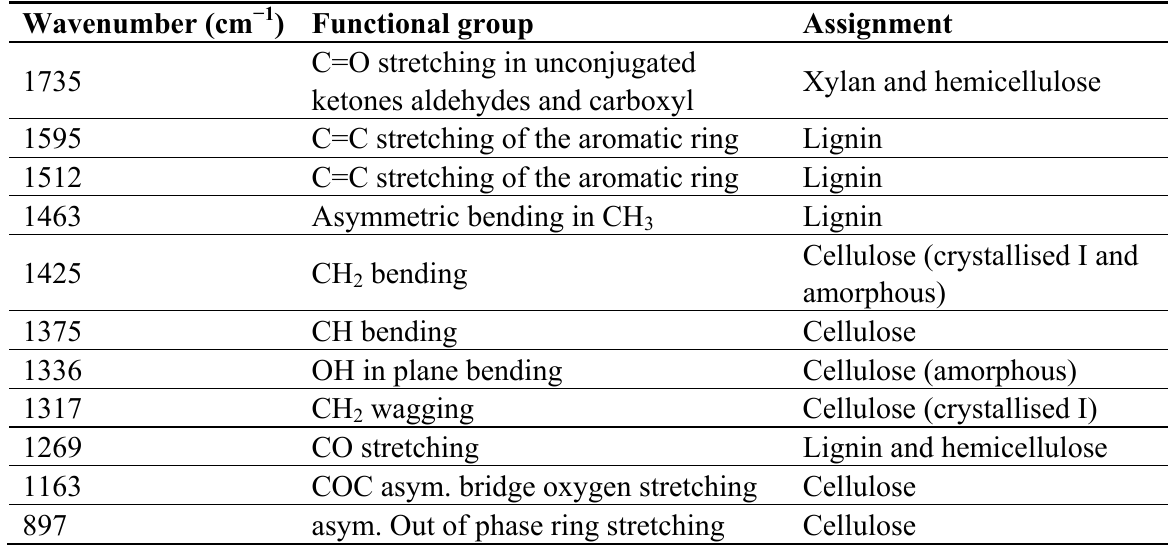
Table 2. Assignments of characteristic absorption IR bands of wood samples in fingerprint